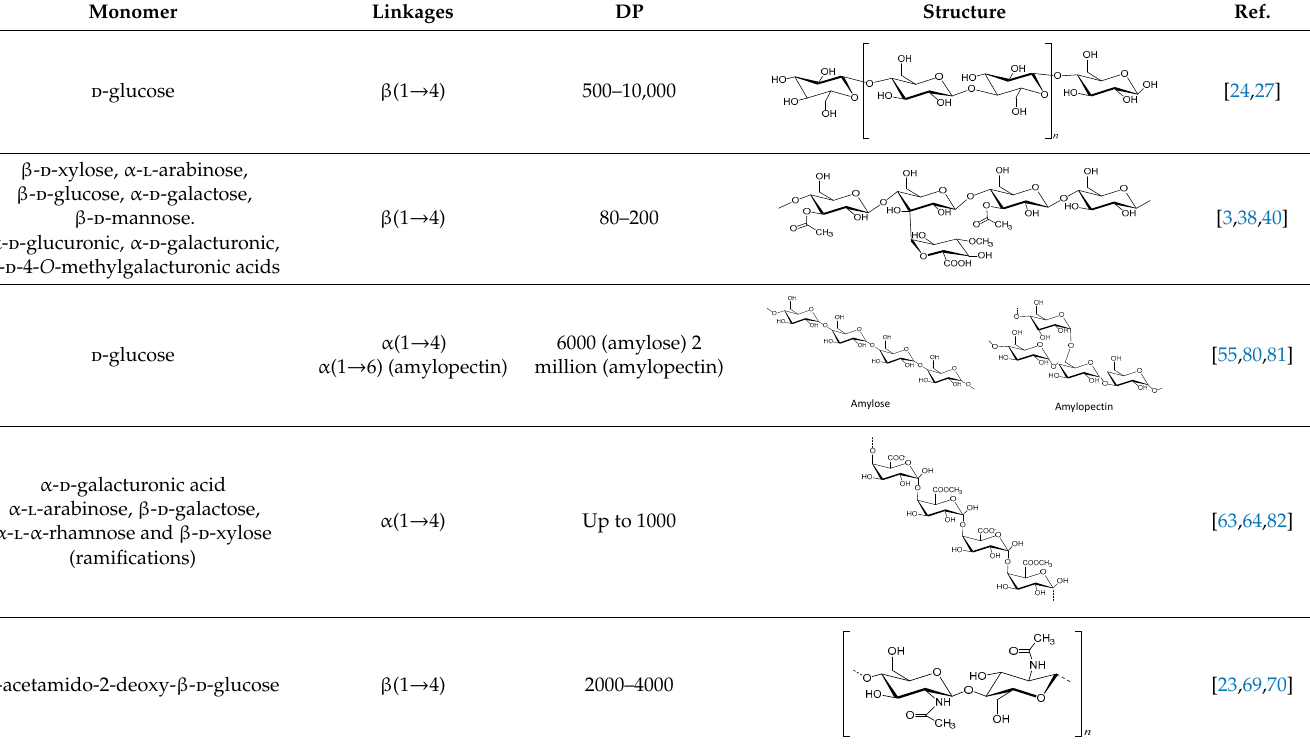
Table 1. Chemical and structural characteristics of polysaccharides mentioned in this work.